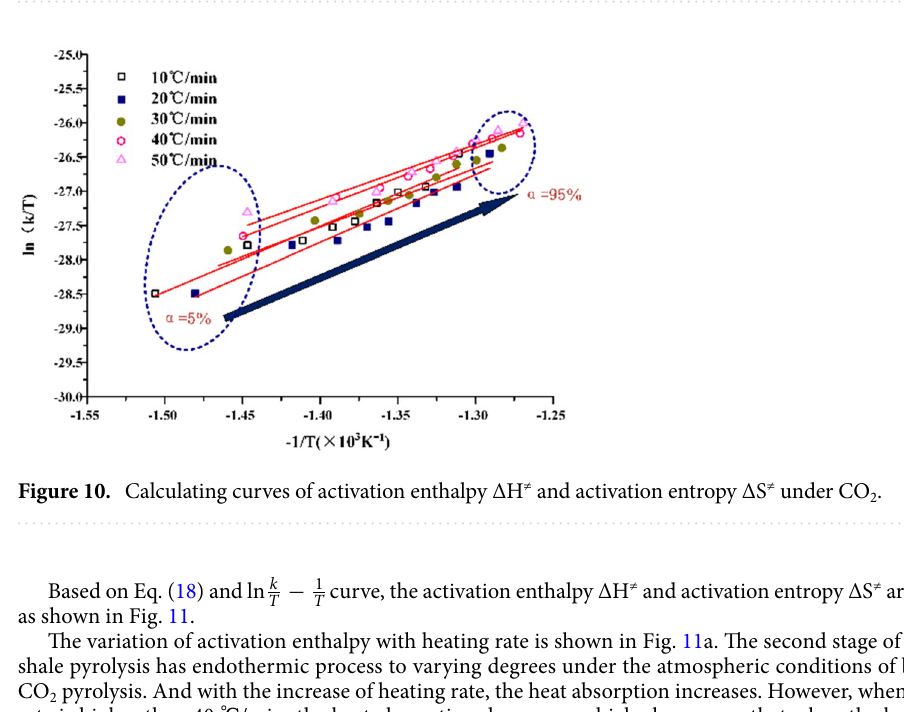
Figure 9. Calculating curves of activation enthalpy ΔH ≠ and activation entropy ΔS ≠ under N 2 .